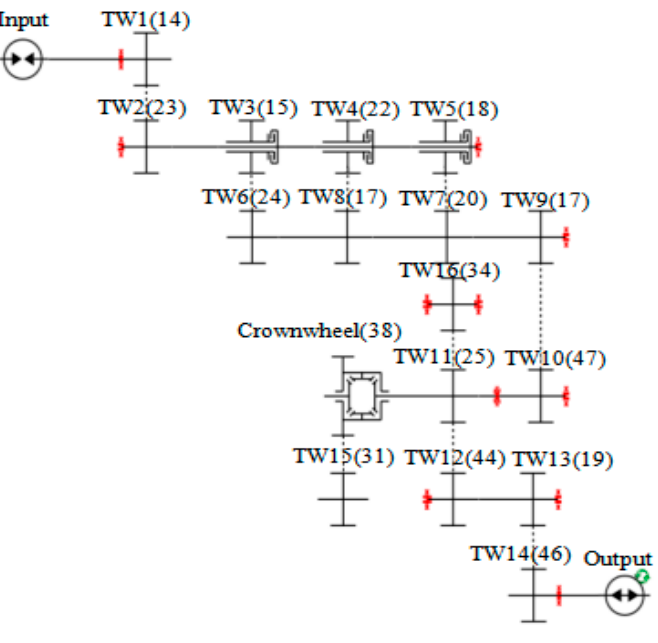
Figure 4. Order calculation model. The red dots are bearings. Table 2. Main order of differential steering gearbox in each gear.